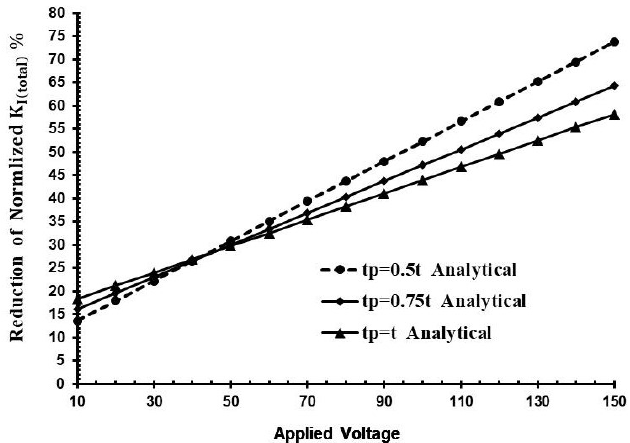
Figure 9. Gain of SIFs with different thickness.